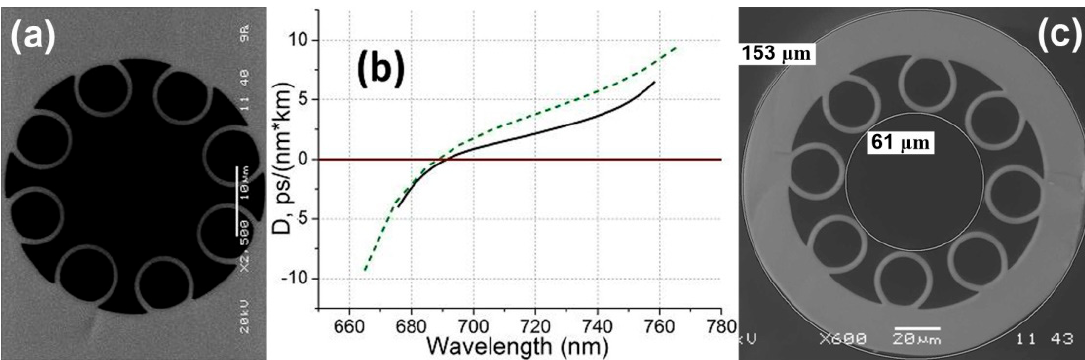
Figure 15. ( a ) RF SEM cross section image [78]; ( b ) Measured (solid black line) and simulated (dashed green line) group velocity dispersion(GVD) of the fiber used in experiments at 748 nm wavelength [78]; and, ( c ) Cross-section image of RF used in experiments at 1560 nm [35].